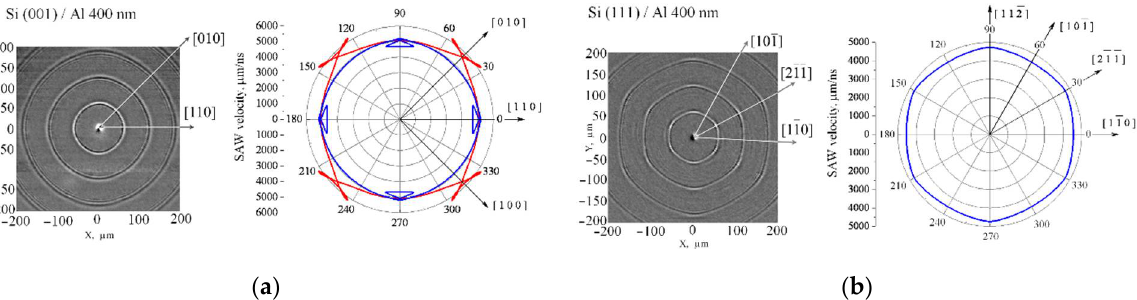
Figure 3. ( a ) Silicon sample with orientation (001); ( b ) Silicon sample with orientation (111). Experimentally registered diverging SAW on silicon surface covered by aluminium film (left). Calculated SAW group velocity (right).